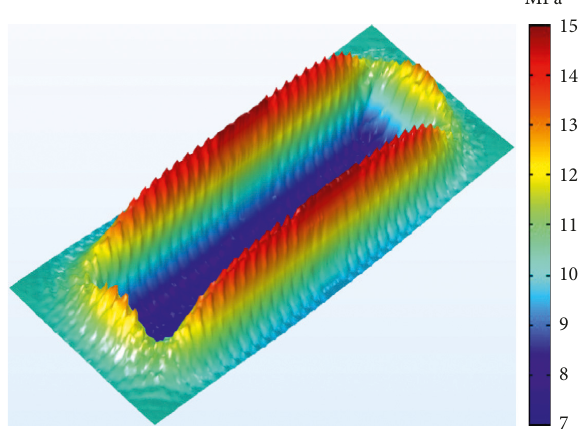
Figure 4: Vertical stress distribution of the protected coal